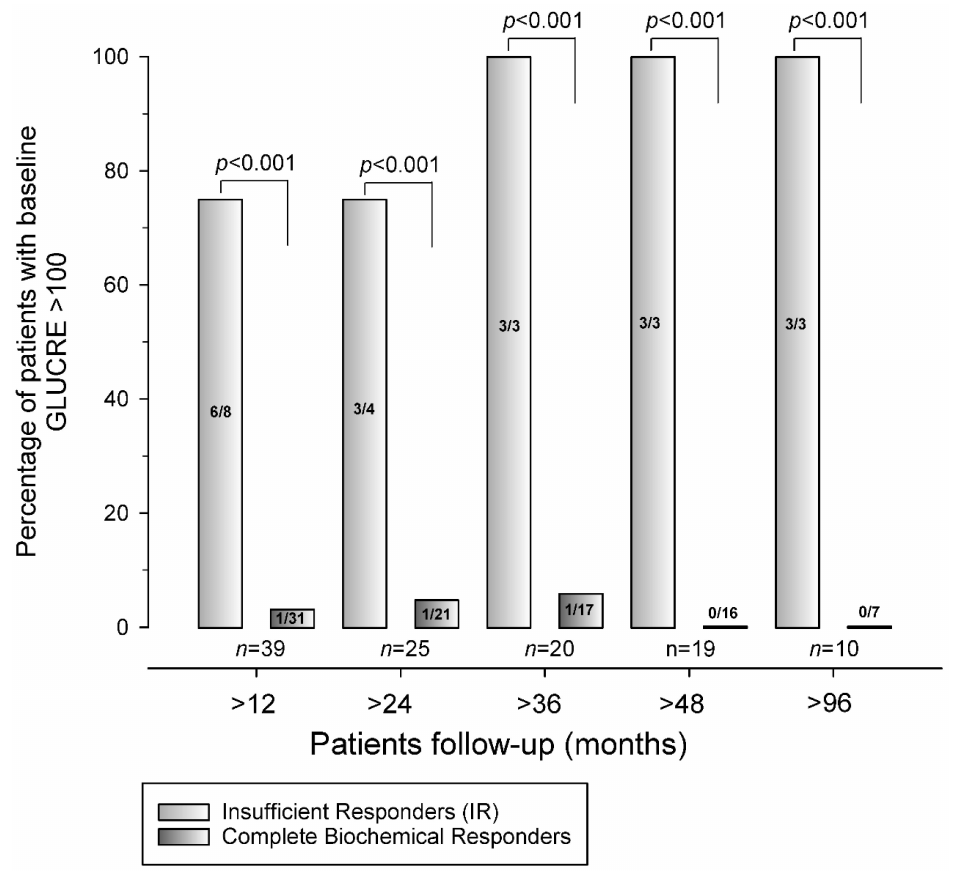
Figure 2. Correlation between the GLUCRE score [obtained by the multiplication of serum creatinine (mg/dL) and glucose (mg/dL) levels] > 100 and the achievement of complete biochemical response (CBR) at different times of